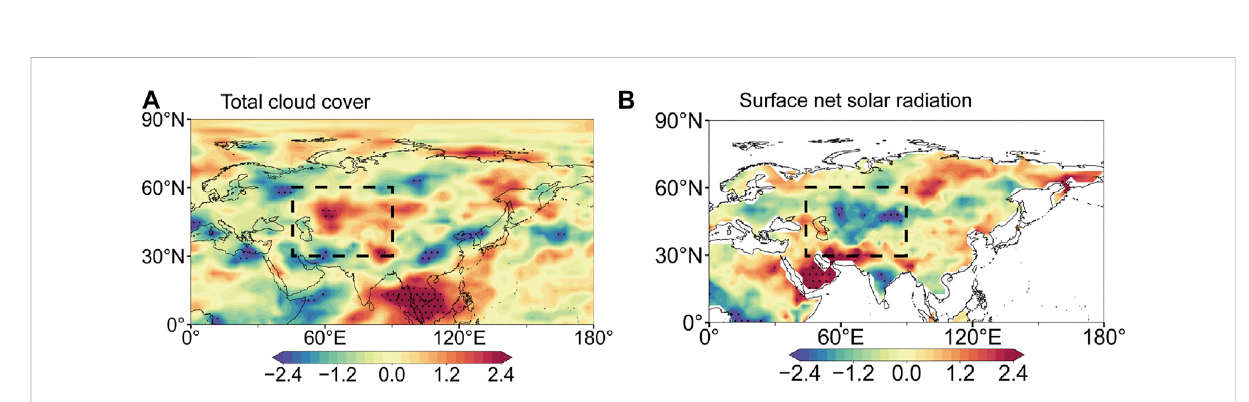
FIGURE 8 Compositedifferences (HS minus LS) of totalcloud cover (A) surface netsolar radiation (B) (units: J · m − 2 ) during 1901 – 2010. during 1901 – 2010. Central Asia (30 ° N – 60 ° N and 50 ° E – 90 ° E) is marked by the black dashed